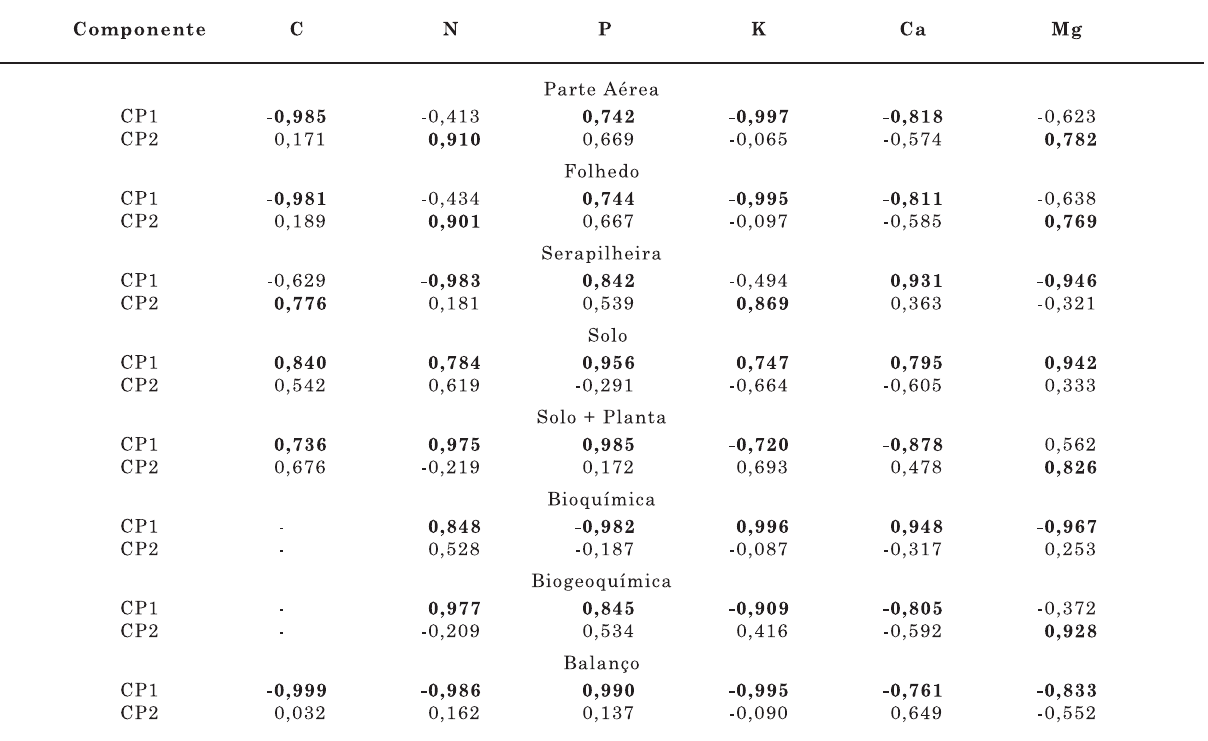
Quadro 7. Cargas relativas das diferentes variáveis associadas aos componentes principais (CP), nos compartimentos do sistema solo-planta, da ciclagem bioquímica e biogeoquímica e do balanço de C e nutrientes do plantio misto, capoeira e floresta natural. (Em negrito, cargas > 0,70 usadas para interpretar cada componente